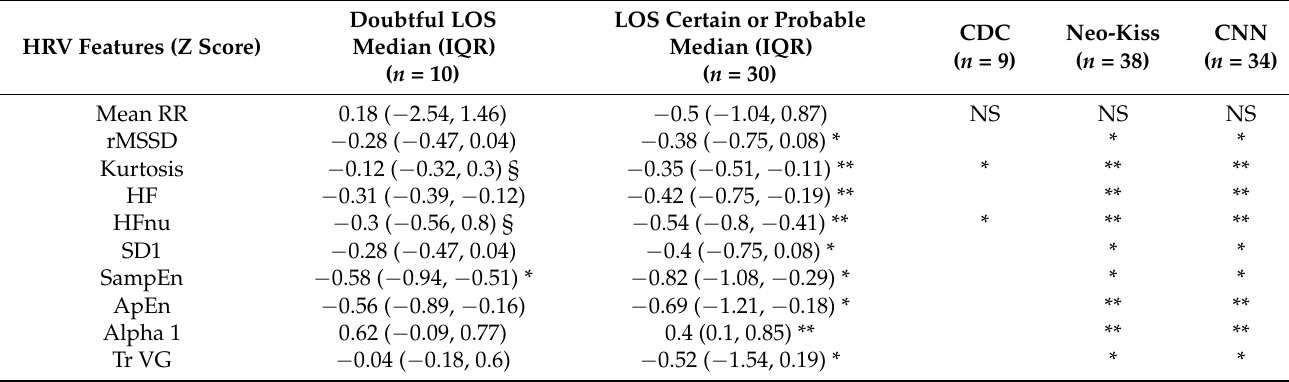
Table 4. Heart rate variability (HRV) parameters: “certain or probable” vs. “doubtful “LOS between T0 − 6 h and T0 + 6 h. The results are therefore expressed as Z scores (i.e., ((observed value—mean of the reference period)/standard deviation from the reference